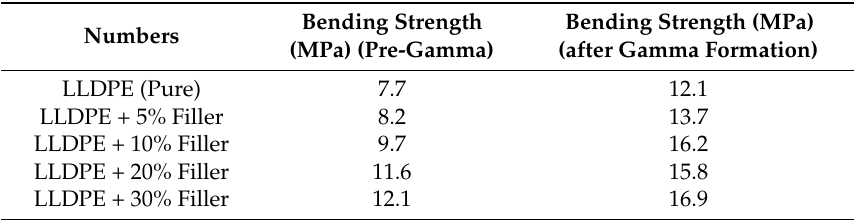
Table 5. Comparative presentation of polyethylene matrix specimen bending strength findings before and after radiation.